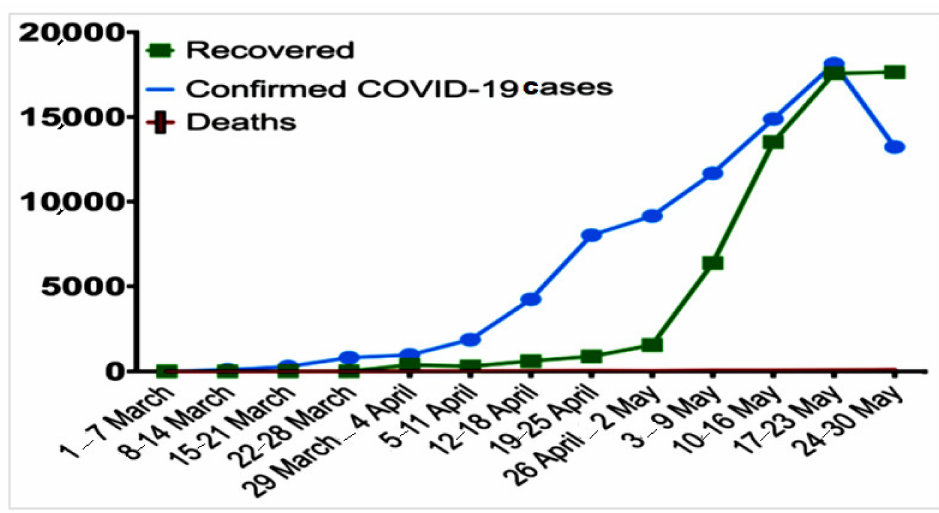
Figure 1. Number of confirmed deaths and recovered cases of the COVID-19 infection in Saudi Arabia from 1 March to 30 May 2020. The data are presented by weeks since the report of the first positive case in the country